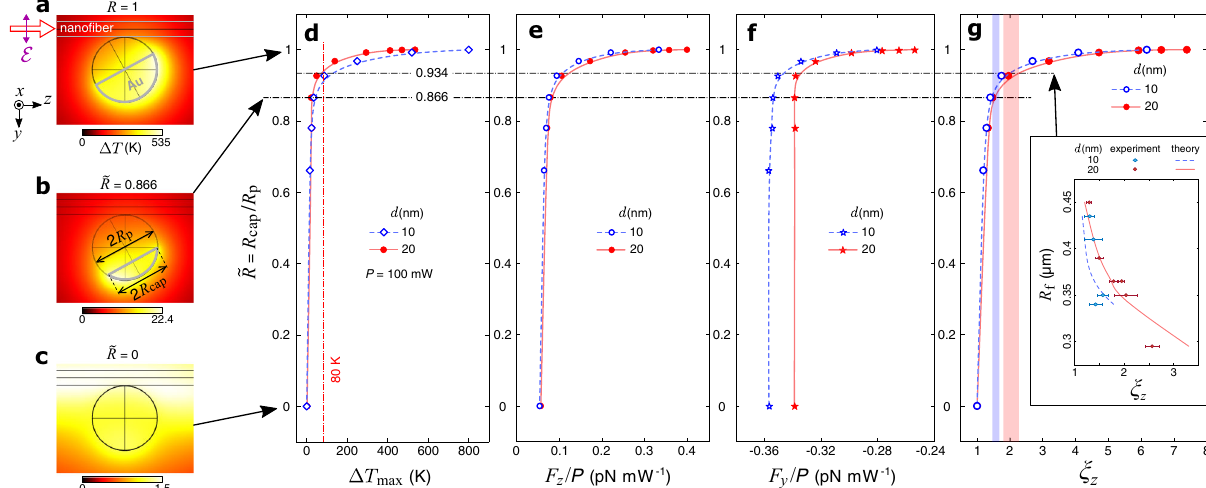
Fig.7|Simulationswithareducedgoldcap.a – c Distributionsofthetemperature increase, Δ T = T − T 0 (withrespecttotheroomtemperatureof T 0 =20 ∘ C=273.15K), around a Janus particle ( R p =1.5 μ m, d =20nm, α 0 =28.5 ∘ ) near an ONF ( R f =0.35 μ m, P =100mW)inwater.Thegoldcaphasavariablebaseradius, R cap ;( a ) same as in Fig. 2a ( R cap = R p ), ( b ) slightly reduced ( R cap =0.866 R p ), ( c ) reduced to zero (no coating). d Maximum temperature increase (for P =100 mW), ( e ) long- itudinal and ( f ) radial optical forces (reduced by P ), ( g ) propulsion enhancement simulated for a Janus particle with a reduced gold cap, ~ R = R cap = R p ≤ 1, the two